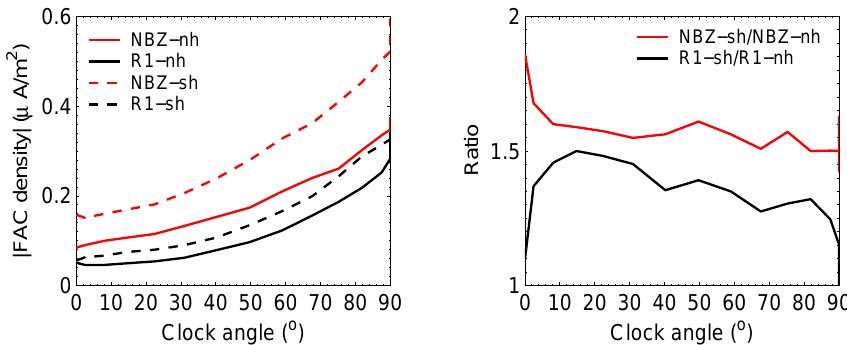
Fig. 5. Left is the peak density of the dominant NBZ and R1 FACs in both hemispheres as a function of the clock angle which has been time shifted from the upperstream boundary to the ionosphere. The solid lines denote the Northern Hemisphere and the dashed lines the Southern Hemisphere. Red is for NBZ FACs and black is for R1 FACs. Right are the ratios between FACs densities in the Southern Hemisphere and those in the Northern Hemisphere